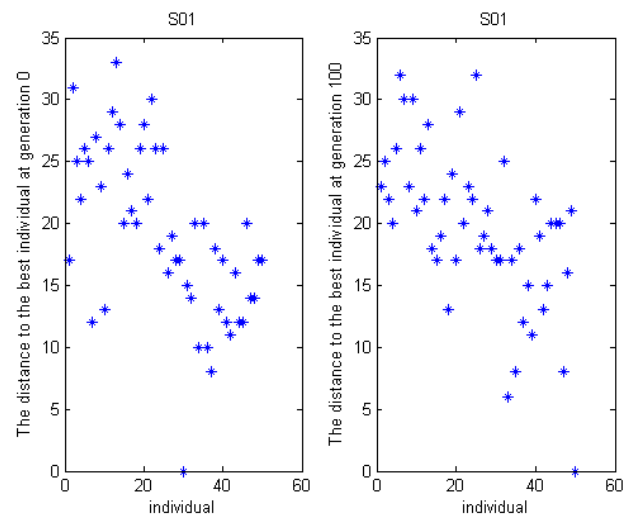
Figure 14. The distance to the best individual for S01.